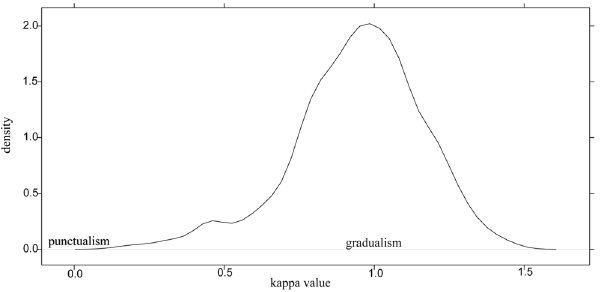
Figure 4. Density distribution of maximum likelihood tree-scaling parameter kappa values across 1000 Bayesian post burn-in phylograms for Agrodiaetus species.